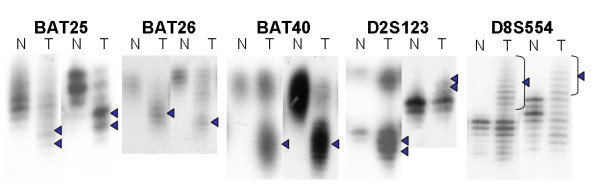
MSI at mono- and dinucleotide repeat markers in type I endometrial carcinioma. Alterations in the electrophoretic mobility of PCR products from tumor compared with normal tissue DNA are seen (arrowheads). (N: normal, T: tumor).